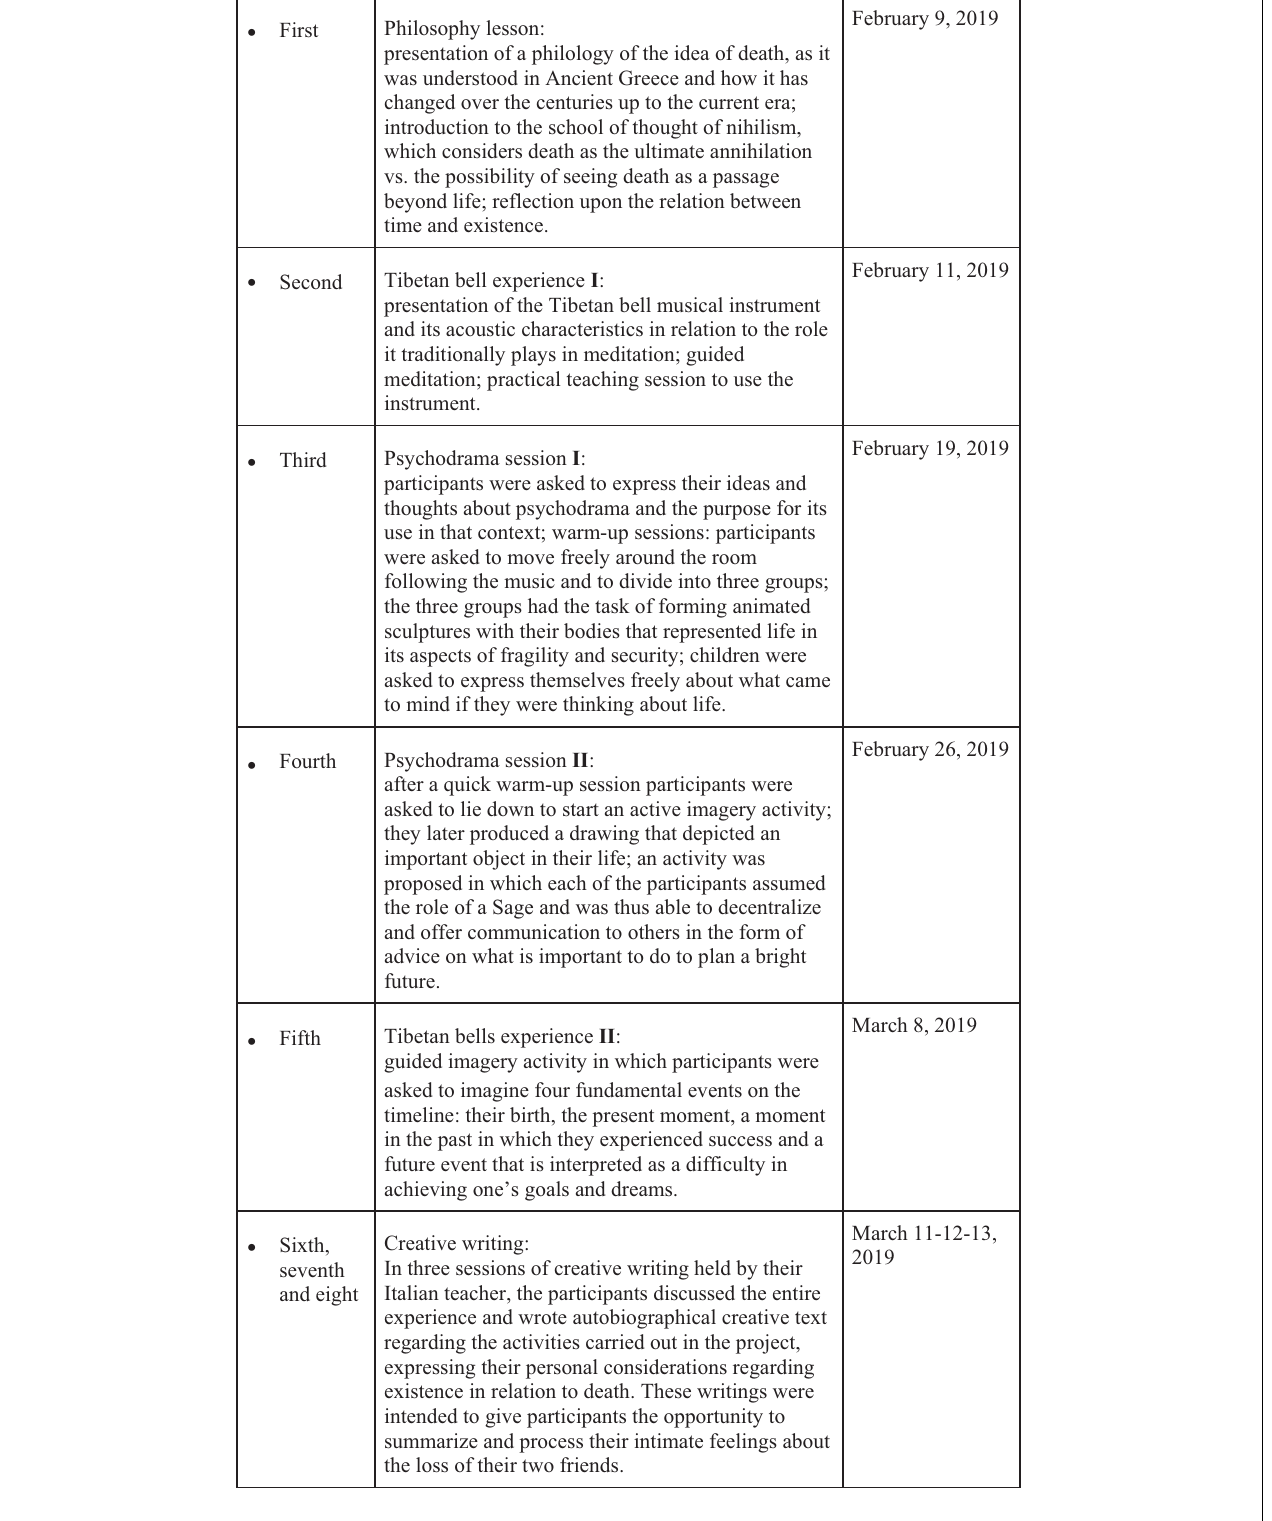
FIGURE 1 | Structure of the